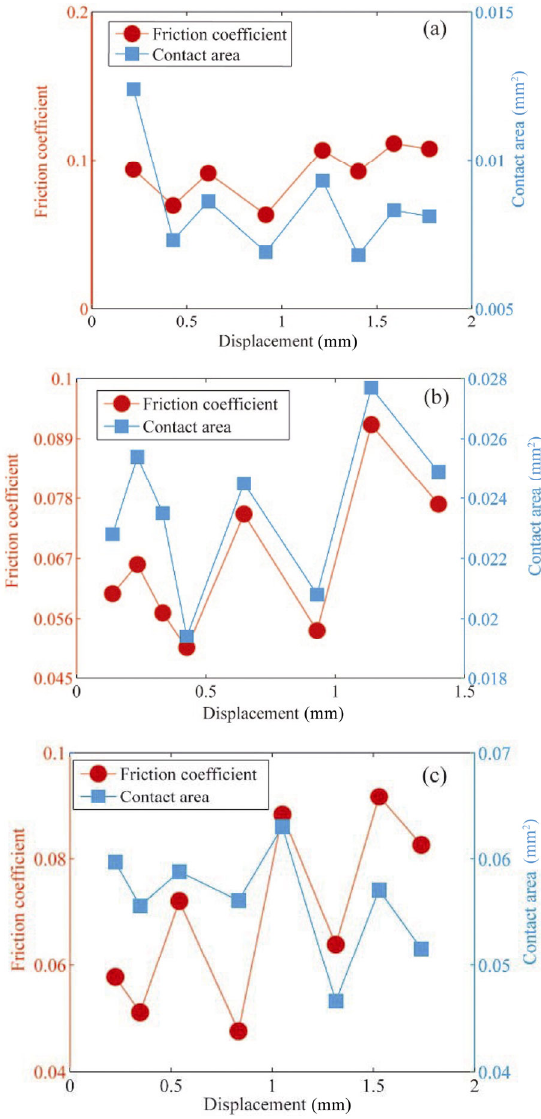
Fig. 8 Correspondence between the friction coefficient and contact area at a velocity of 0.2 mm/s and loads of (a) 1 N, (b) 3 N, and (c) 7 N, respectively.